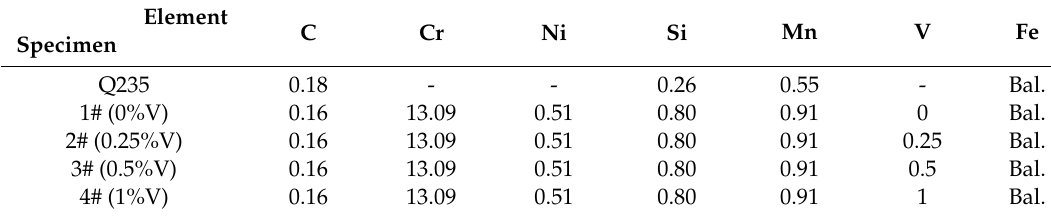
Table 1. Chemical compositions (wt%) of the substrate and powders and the corresponding specimen